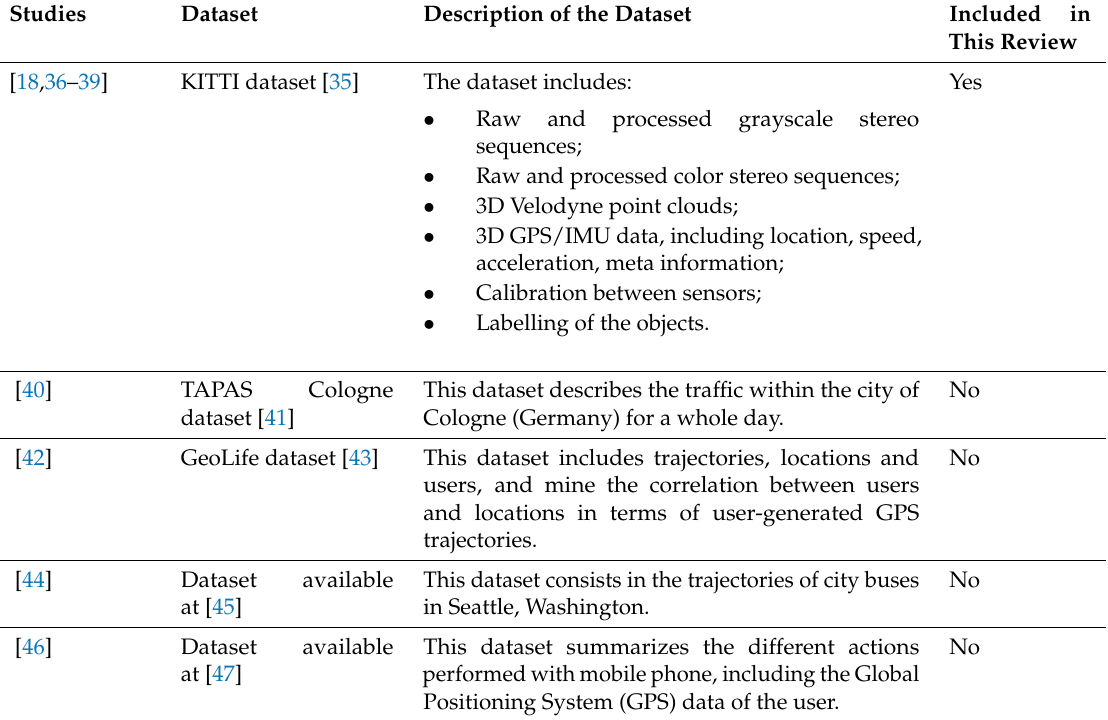
Table 4. Dataset analysis of all searched